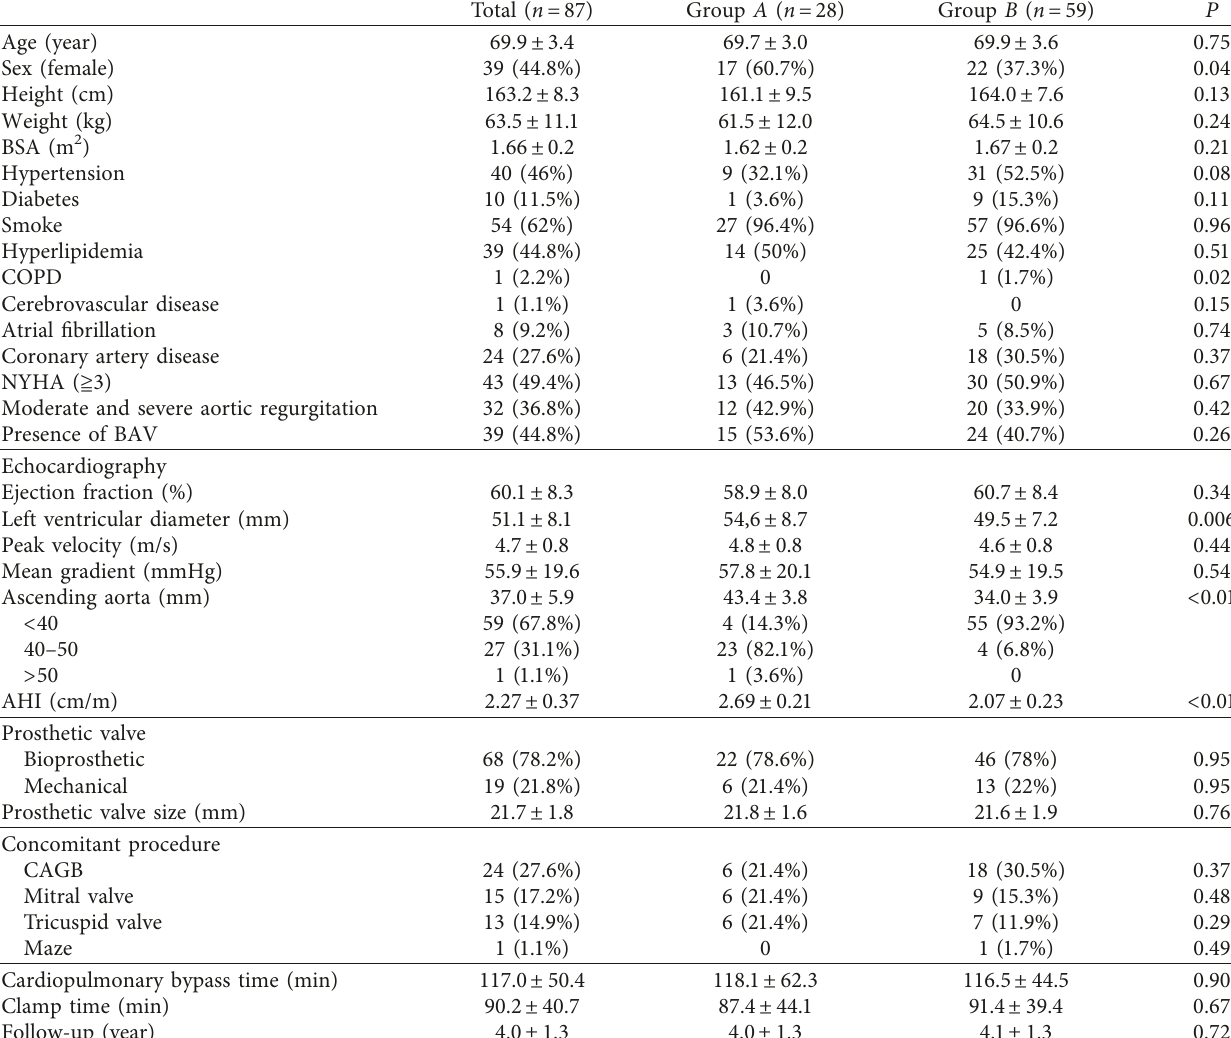
Table 1: Patient